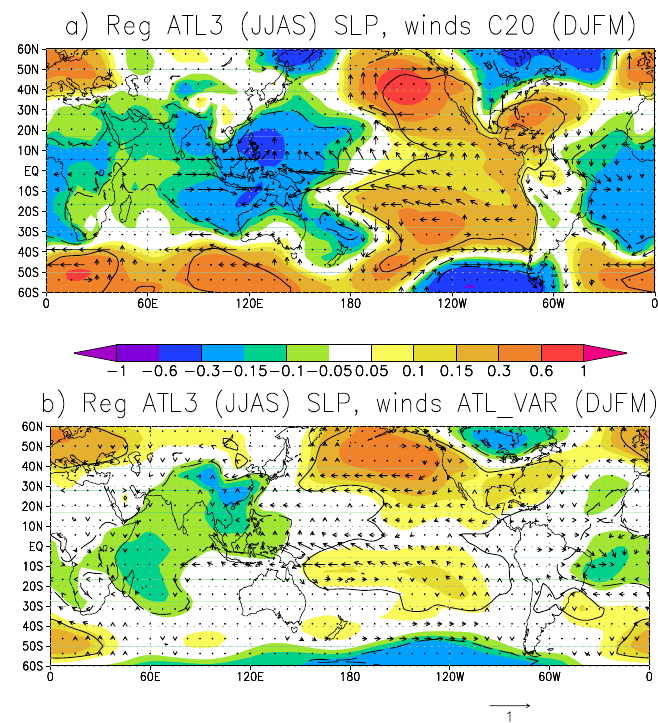
Figure 2. Regression of ( a ) observed and ( b ) ATL_VAR SLP and low-level winds (DJFM) onto preceeding (JJAS) ATL3 index. SLP anomalies that are 95% statistically significant are indicated by contours, and only statistically significant wind vector components are shown. Units are hPa for SLP and m/s for